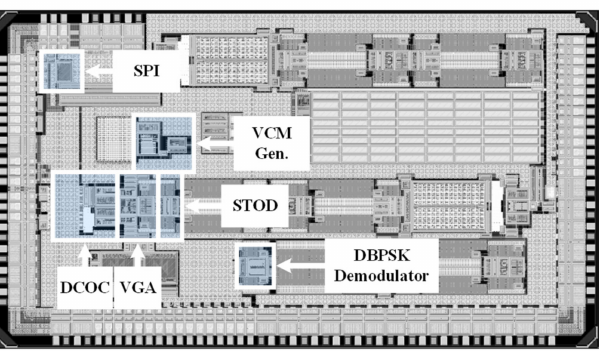
Figure 8. The top layout of the chip and location of AFE, DBPSK demodulator, SPI, and VCM Gen.